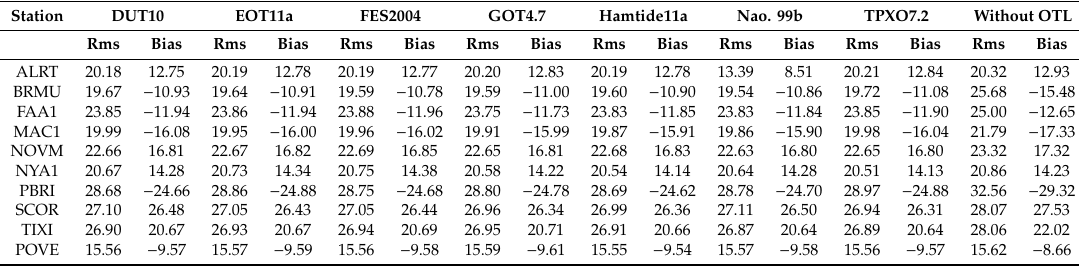
Table 4. The statistic presented in this table is the di ff erence between the GNSS-derived ZTD and the ZTD derived from the co-located radiosonde station (as a reference), for GNSS stations with a co-located radiosonde station, with comparisons across OTL models.